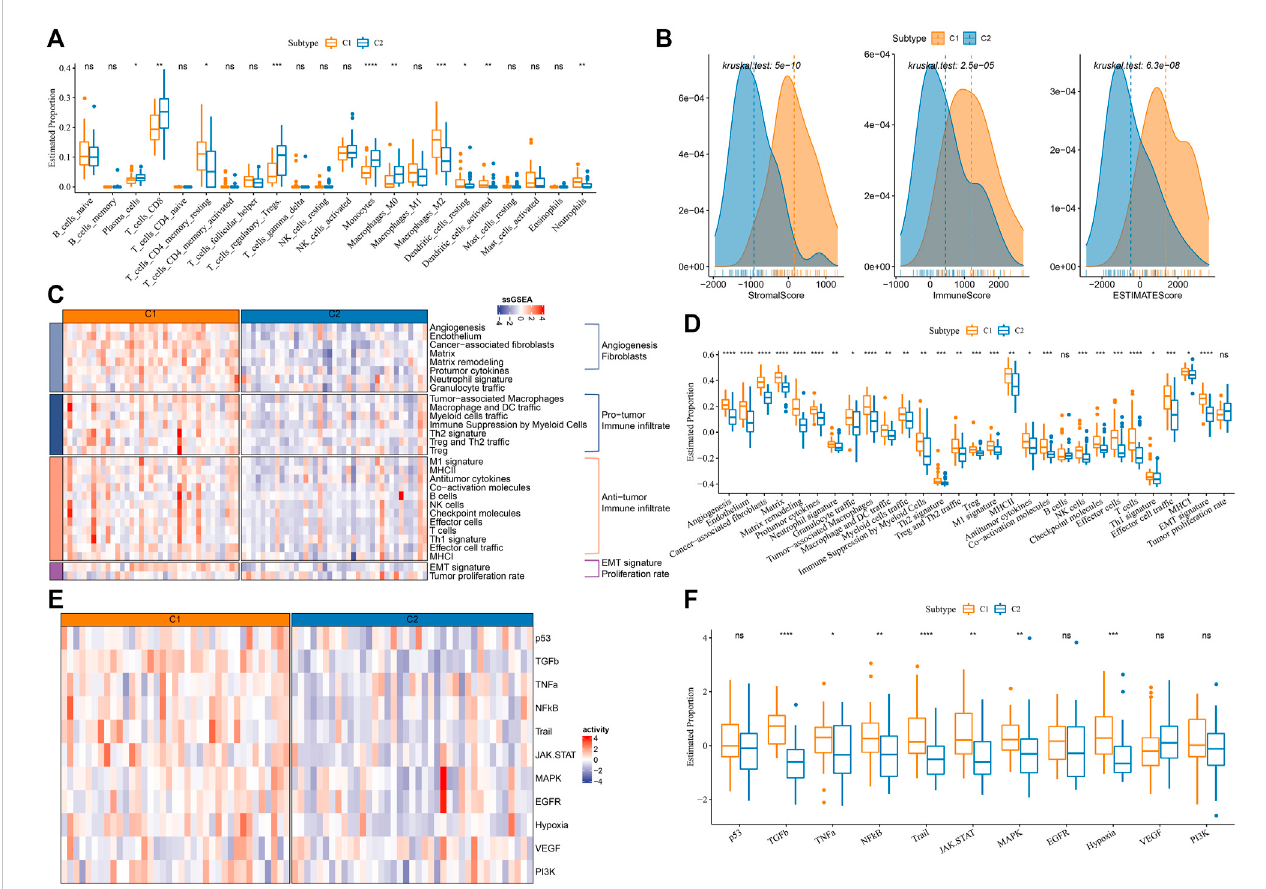
FIGURE 3 Immune characteristics in C1 and C2 of E-MTAB-6389 cohort. (A) The distribution of 22 immune cells in C1 and C2 analyzed by CIBERSORT. Wilcoxon test was conducted. (B) ESTIMATE analysis showed the immune score, stromal score and ESTIMATE score of C1 and C2. (C) Heat map of 29 immune-related signatures inC1 and C2. (D) Box plot showing the ssGSEA score of 29 immune-related signatures inC1 and C2. Wilcoxon test was conducted. (E) Heatmap of oncogenic pathways. (F) Box plot of oncogenic pathways. Wilcoxon test was conducted. ns, not signi fi cant. * p < 0.05, ** p < 0.01, *** p < 0.001, **** p <